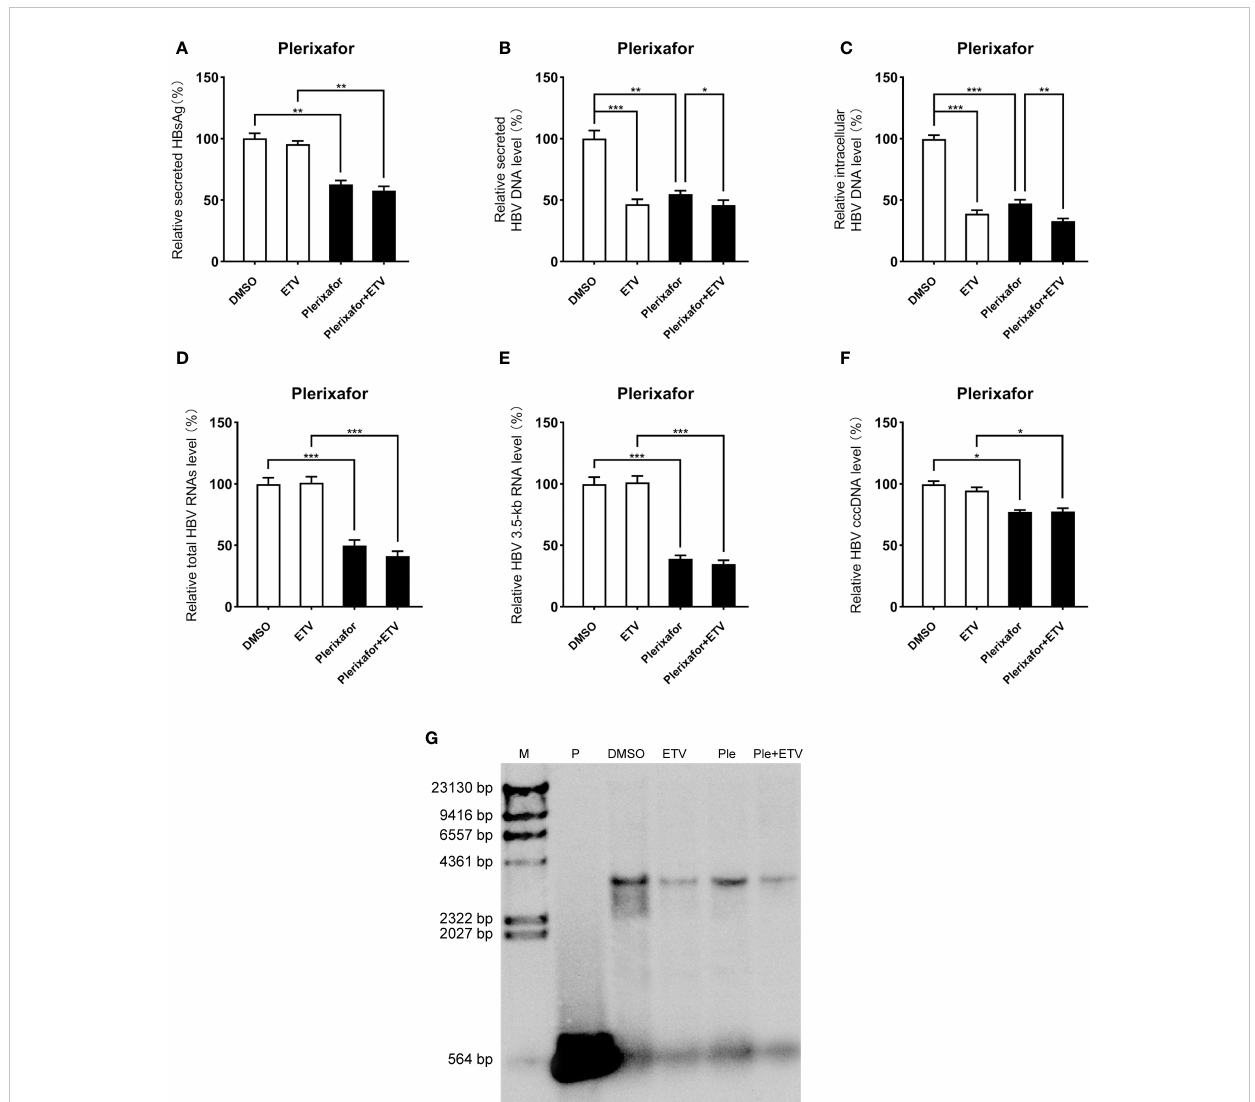
FIGURE 6 Plerixafor showed anti-HBV activity in the HBV infection model. HepG2-NTCP cells were infected with HBV particles (1,000 GEq/cell). Then, the HBV-infected cells were treated with 0.1% DMSO, 0.5 nM plerixafor or/and 25 nM ETV for 10 days. (A) The results of the ELISA showed that plerixafor decreased the HBsAg level in the supernatant. (B-E) Plerixafor signi fi cantly inhibited secreted and intracellular HBV DNA, total HBV RNAs, and the 3.5-kb RNA. (F) Plerixafor partly decreased the level of cccDNA. (G) A Southern blot analysis was performed to determine the reduction of HBV DNA. *, P < 0.05; **, P < 0.01; ***, P <